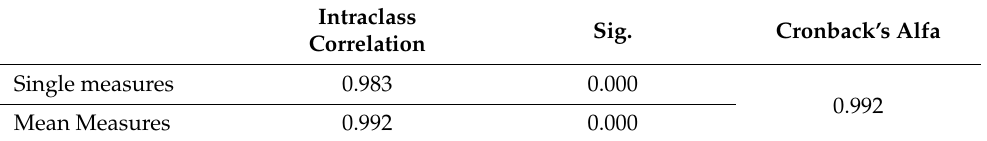
Table 3. ICC and Cronbach’s alpha score between Observation 1 (O 1) and Observation 2 (O 2). Intraclass